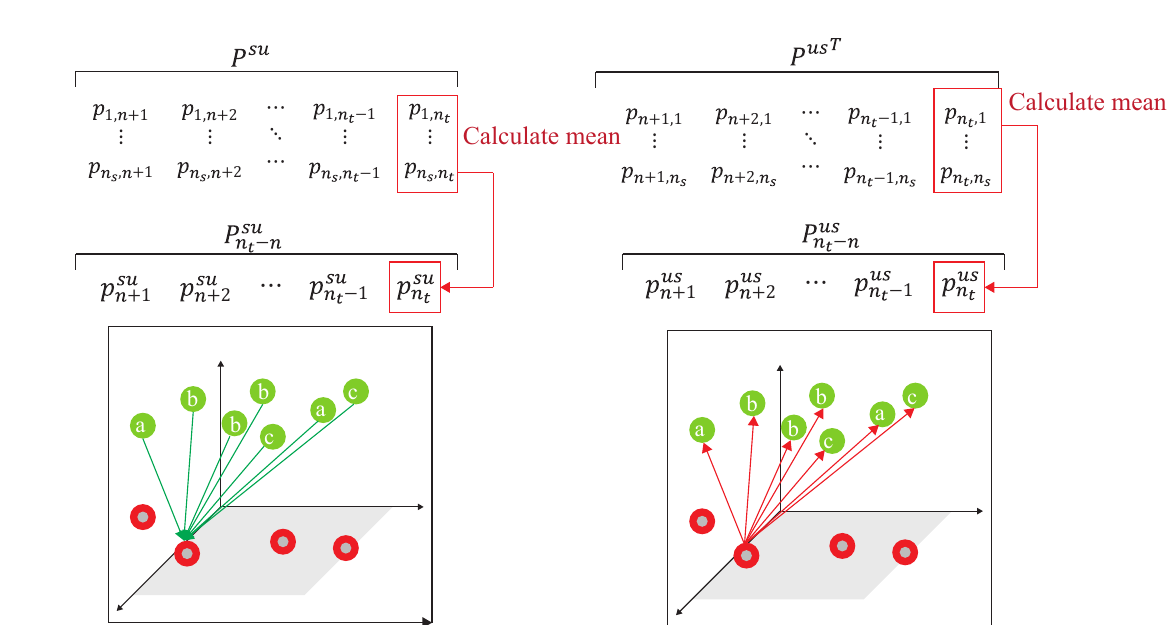
Figure 14. The process of synchronize